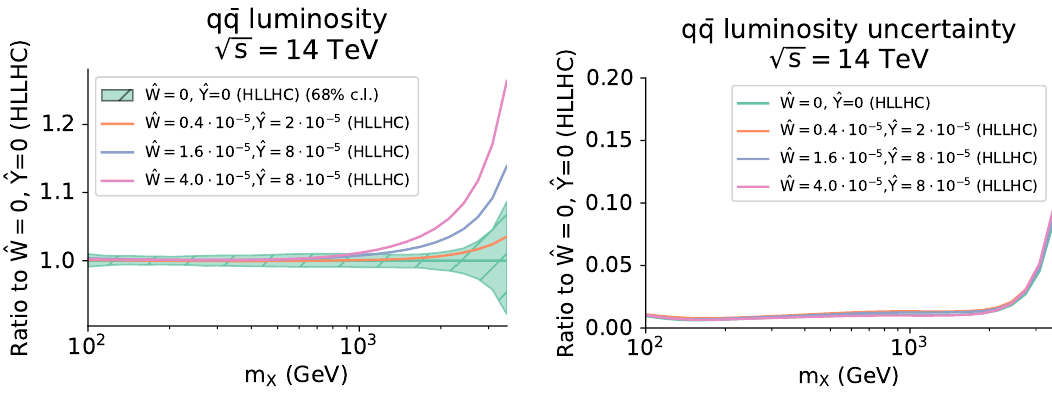
Figure 16 . Same as figure 14, now comparing the quark-antiquark SM PDF luminosity in the fits including the HL-LHC pseudo-data with those obtained in the SMEFT PDF fits for representative values of the ˆ W and ˆ Y parameters. The corresponding comparison in the case of fits to available Drell-Yan data was shown in figure 6.